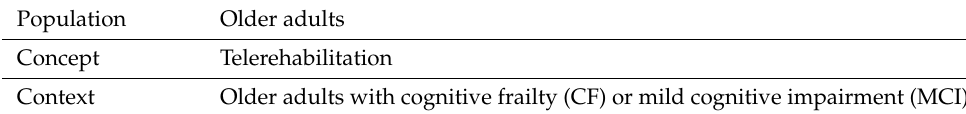
Table 1. Table of